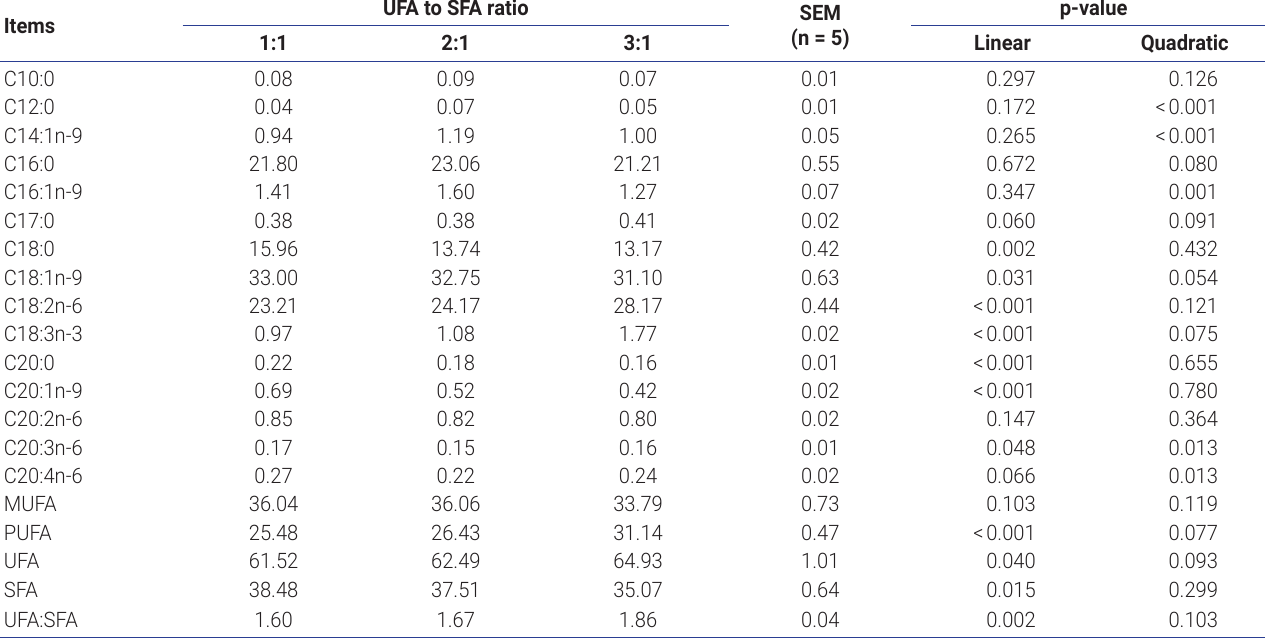
Table 6. Effects of dietary unsaturated to saturated fatty acids ratios on fatty acid composition of subcutaneous adipose (% total fatty